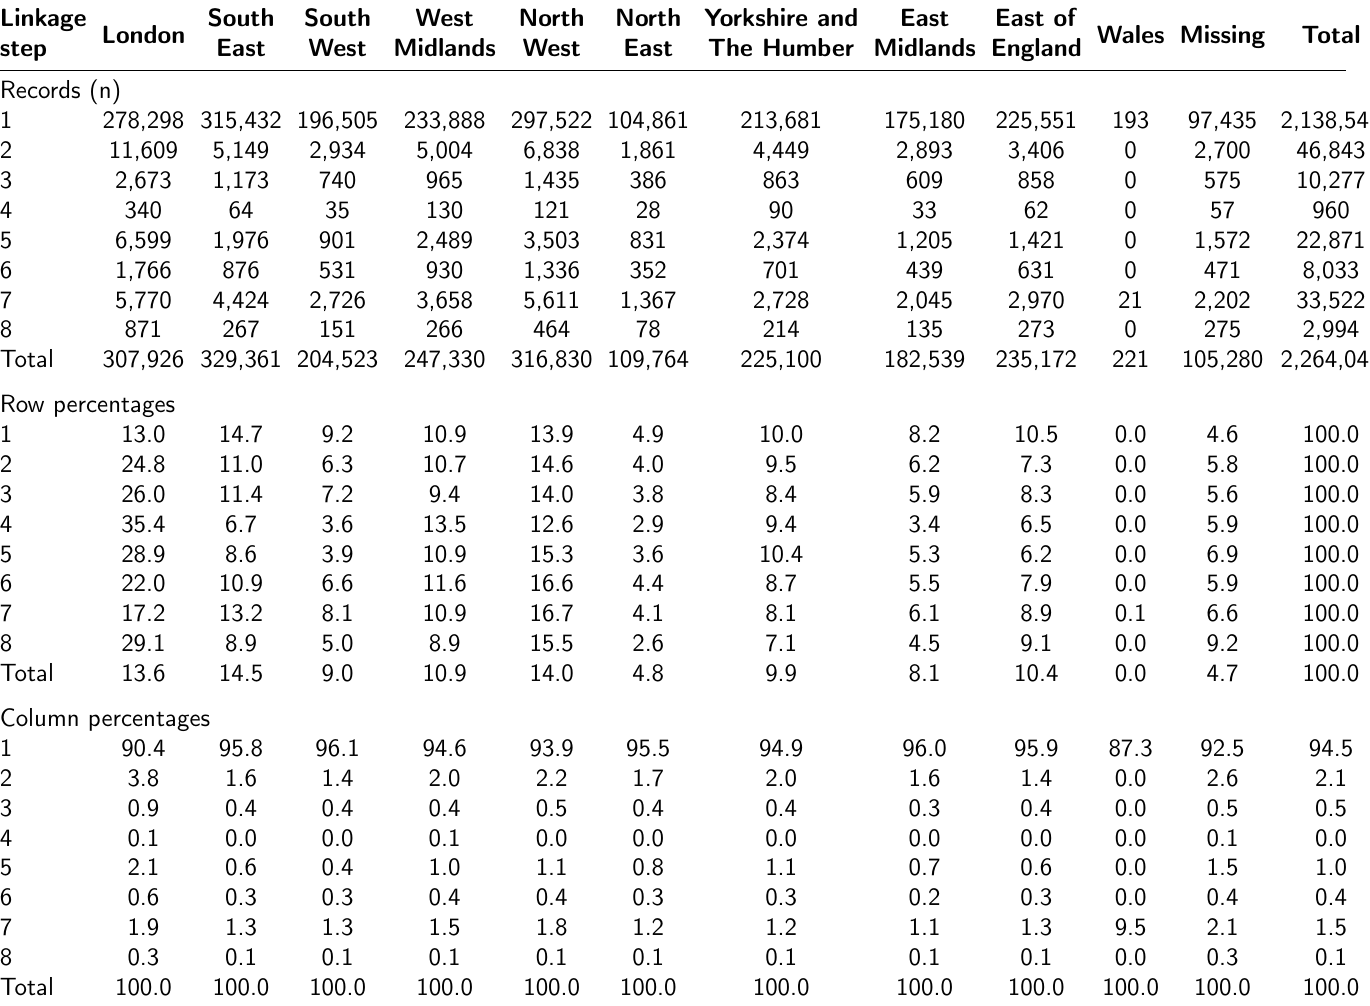
Supplementary Table 7.3: Linkage personal demographics service to hospital episode statistics by linkage step and region (all pairs) Linkage London